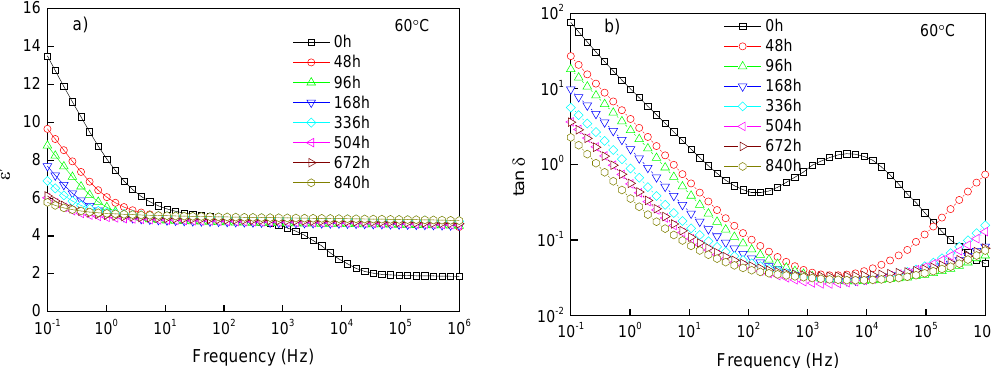
Figure 3. The dependency of real permittivity and loss on frequency at the service temperature of cables, ( a ) the spectrum of real permittivity, and ( b ) the spectrum of tan δ .